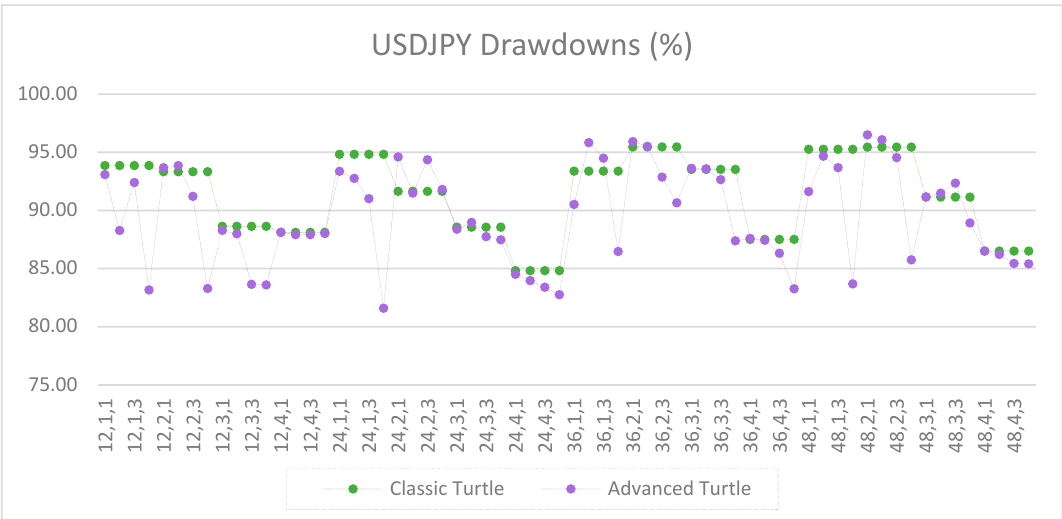
Figure A25. Net profits of USDJPY between the classic and the advanced Turtle systems for every combination of N, X, Y for the medium parameters (40, 80).